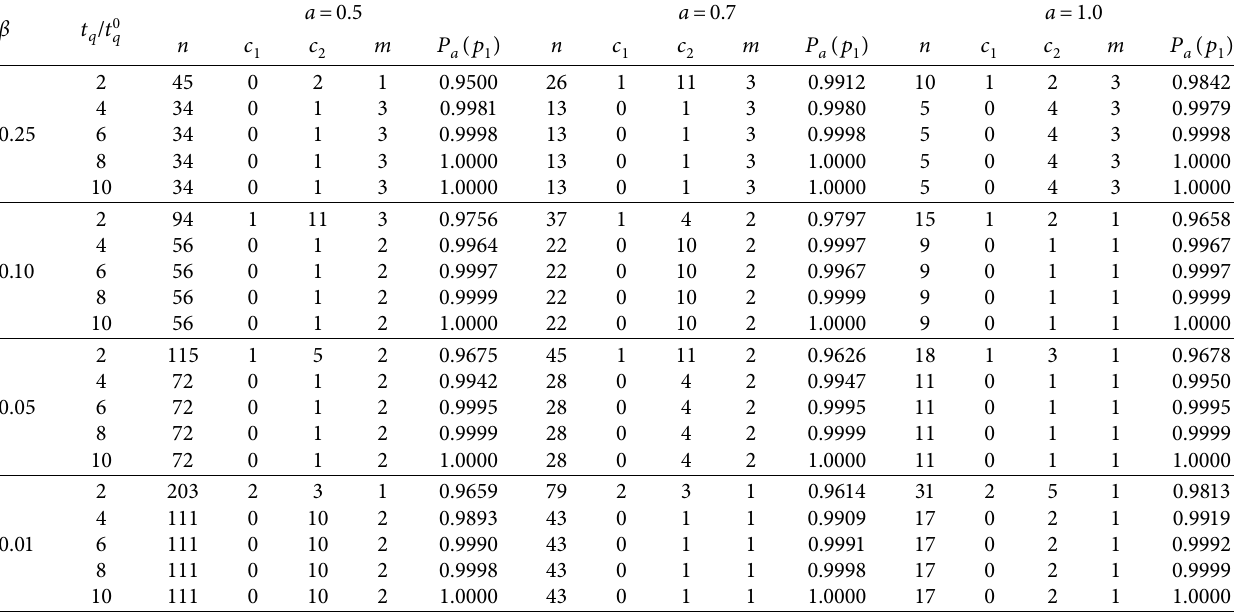
Table 5: Optimal parameters of the proposed MDSSP for EWD with δ � 1 . 5 , c � 2 at 25 th percentile.